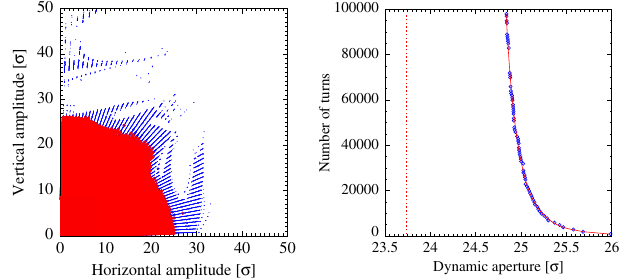
FIG. 1. Left: Dynamic aperture of a model of the LHC ring in normalized physical space. The red points represent initial conditions stable up to the maximum number of turns ( 10 5 ). The blue points represent unstable conditions and the marker ’ s size is proportional to the number of turns for which the motion is still bounded. Right: Time evolution of DA. The markers represent the numerical results, while the continuous line shows the fitted inverse logarithmic law, and the vertical dashed line represents D ∞ (the fit parameters are D ∞ ¼ 23 . 74 (cid:2) 0 . 01 ; b ¼ 0 . 439 (cid:2) 0 . 005 ; κ ¼ 1 . 40 (cid:2) 0 . 05